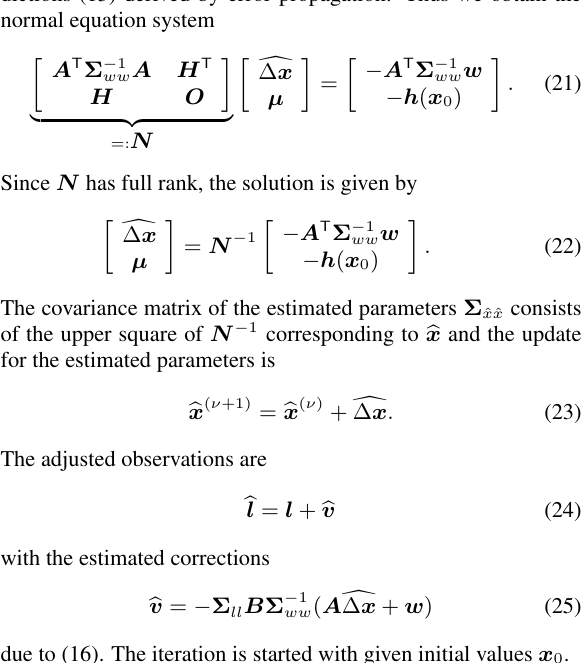
Figure 3: Extracted regions of the first scene.